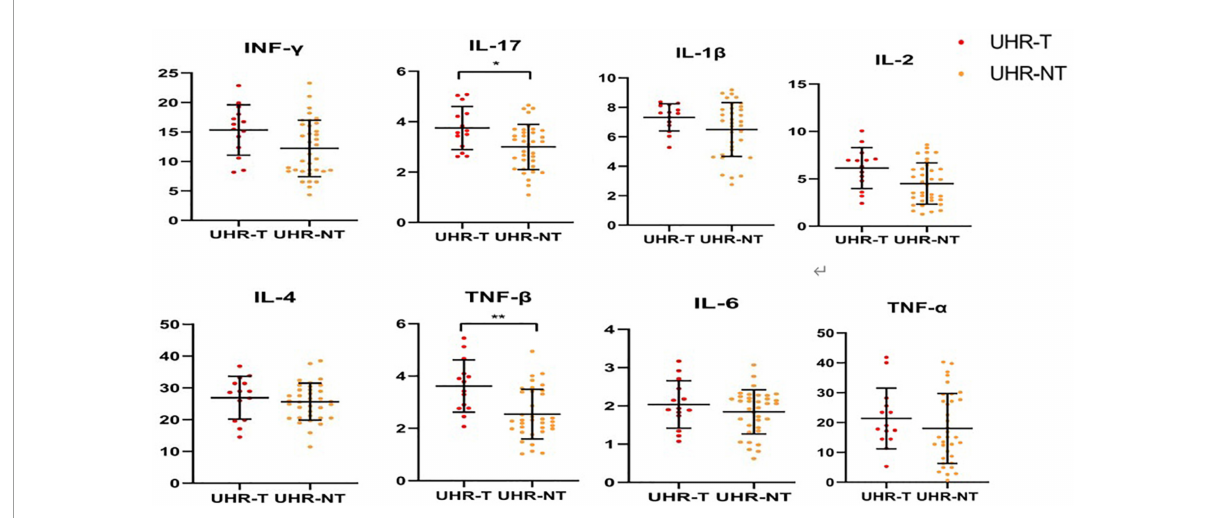
FIGURE2 Comparison of the levels of cytokines among the two groups [UHR-T and UHR-NT, Cytokine concentration (pg/ml)]. IL-17 levels were significantly higher in UHR-T group than UHR-NT group [ p = 0.04, 3.750.86 vs. 3.000.88 pg/ml]. TNF- β levels were significantly higher in UHR-T group than UHR-NT group [ p = 0.008, 3.621.00 vs. 2.540.95]. *The difference is significant with a p -value of less than 0.05. **The difference is significant with a p -value of less than 0.01. UHR-NT, ultra-high-risk without transition; UHR-T, ultra-high-risk with transition.